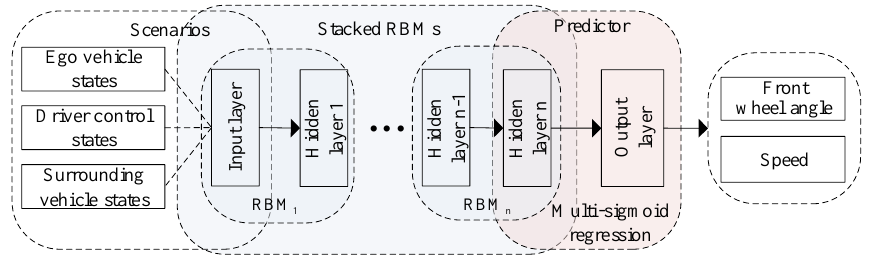
Figure 2. The typical DBN driving behavior prediction